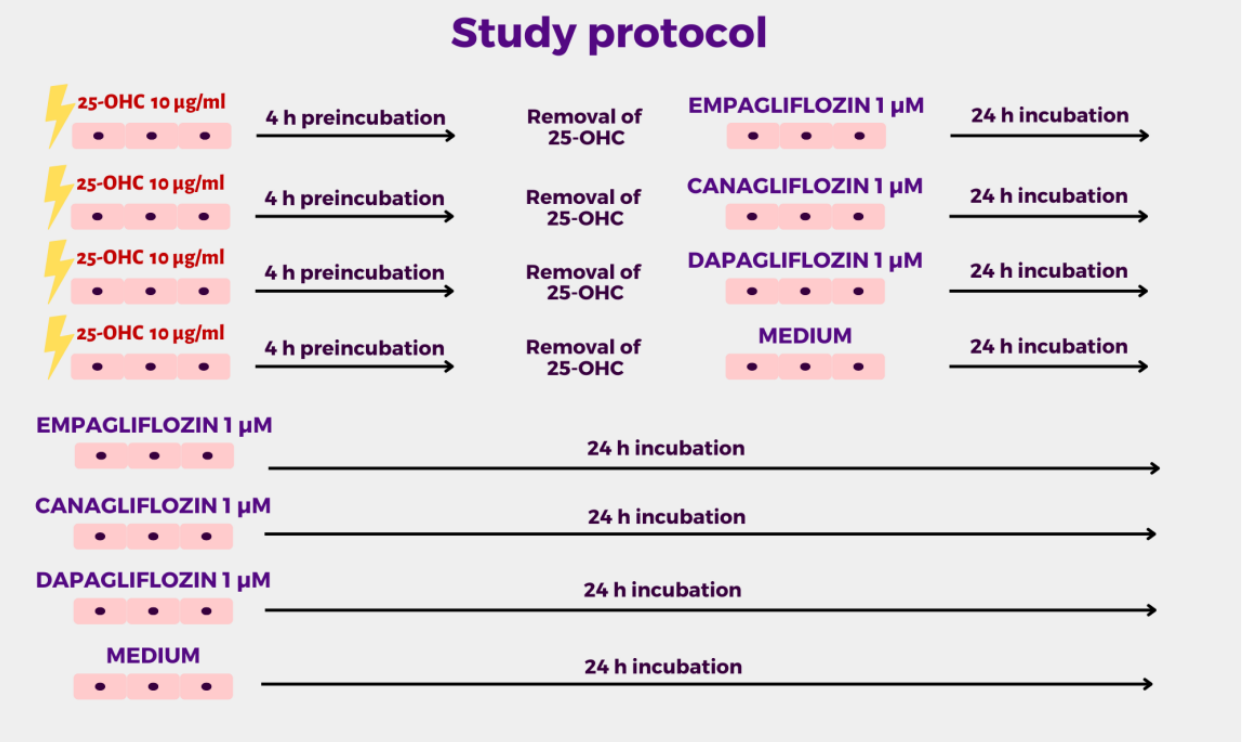
Figure 4. Study protocol.